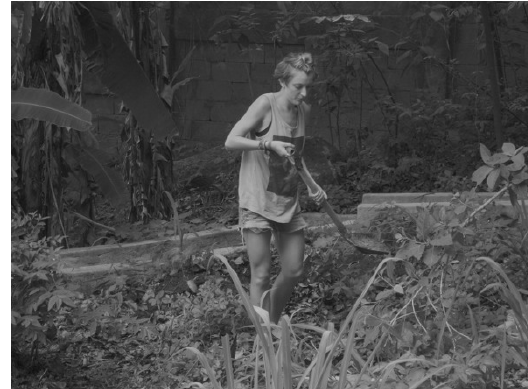
Figure 11. GMF at work in the ecopark, the ‘eco/segregation wall’ in the